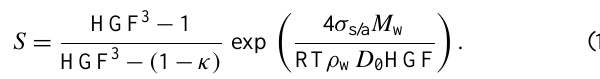
a The geometric mean diameter of each impactor stage is the square root of the product of the lower limit multiplied with the corresponding upper limit. b The campaign’s average volume equivalent diameter of dry particles are evaluated from the iterative algorithm in Sect.